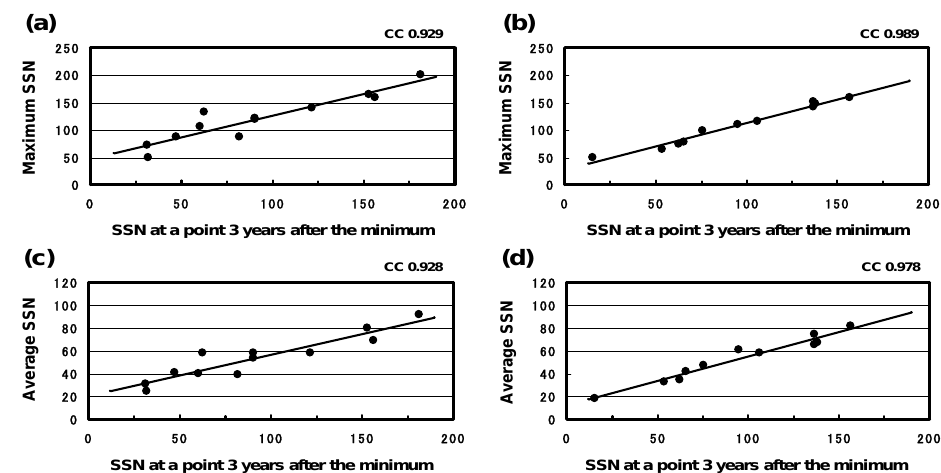
Figure 2. (a) Scatterplot of maximum SSN versus SSN 3 years after the minimum for odd-numbered cycles. (b) Same as panel (a) but for even-numbered cycles. The correlation coefficient and its lower and upper limits of the 95% confidence interval are 0.929, 0.762 and 0.980 for the former case, while those for the latter case are 0.988, 0.955 and 0.997, respectively. (c) Scatterplot of average SSN versus SSN 3 years after the minimum for odd-numbered cycles. (d) Same as panel (c) but for even-numbered cycles. The correlation coefficient and its lower and upper limits of the 95% confidence interval are 0.928, 0.759 and 0.980 for the former case, while those for the latter case are 0.978, 0.914 and 0.994,